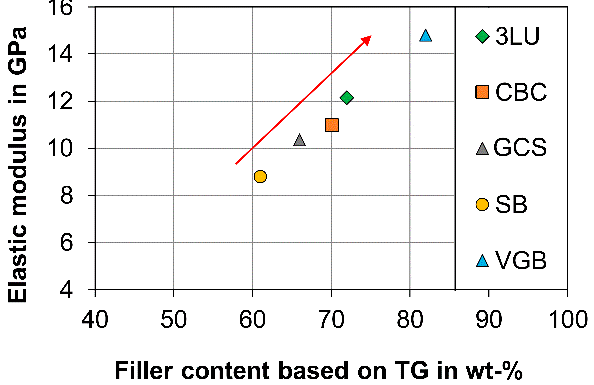
Figure 7. Filler content as identified by TG in correlation with the elastic modulus (manufacturer’s data) for indirect RBCs (3LU-Lava Ultimate, CBC-BRILLIANT Crios, GCS-Cerasmart, SB-Shofu Block HC, VGB-Grandio blocs).